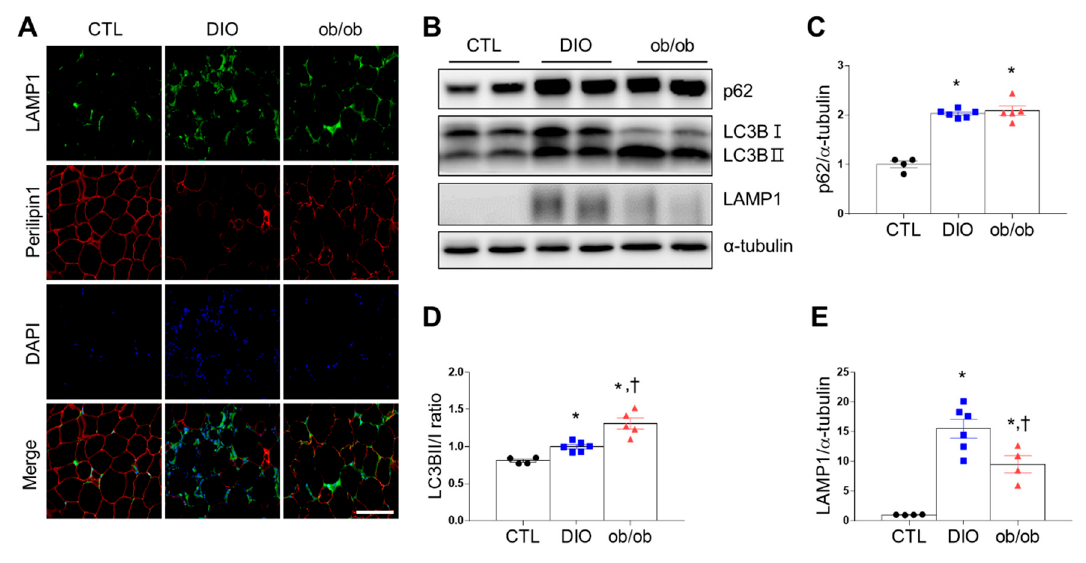
Figure 4. E ff ects of high-fat diet and leptin deficiency on autophagy in adipose tissue. ( A ) Representative immunofluorescent images (200 × ) of lysosomal-associated membrane protein 1 (LAMP1) (green), perilipin 1 (red), and 4 (cid:48) ,6-diamidino-2-phenylindole (DAPI) (blue) in adipose tissue. ( B ) Western blot analysis of p62, LC3B, and LAMP1 protein expression, using α -tubulin as a reference protein. ( C – E ) Quantitative Western blot analysis of p62 ( C ), LC3BII / I ratio ( D ), and LAMP1 ( E ) in adipose tissue. Data are presented as the means ± SEM. * p < 0.05 versus control (CTL) mice; † p < 0.05 versus diet-induced obesity (DIO) mice. Scale bar = 100 µ m. CTL (black circle), DIO (blue square), ob / ob (red triangle).